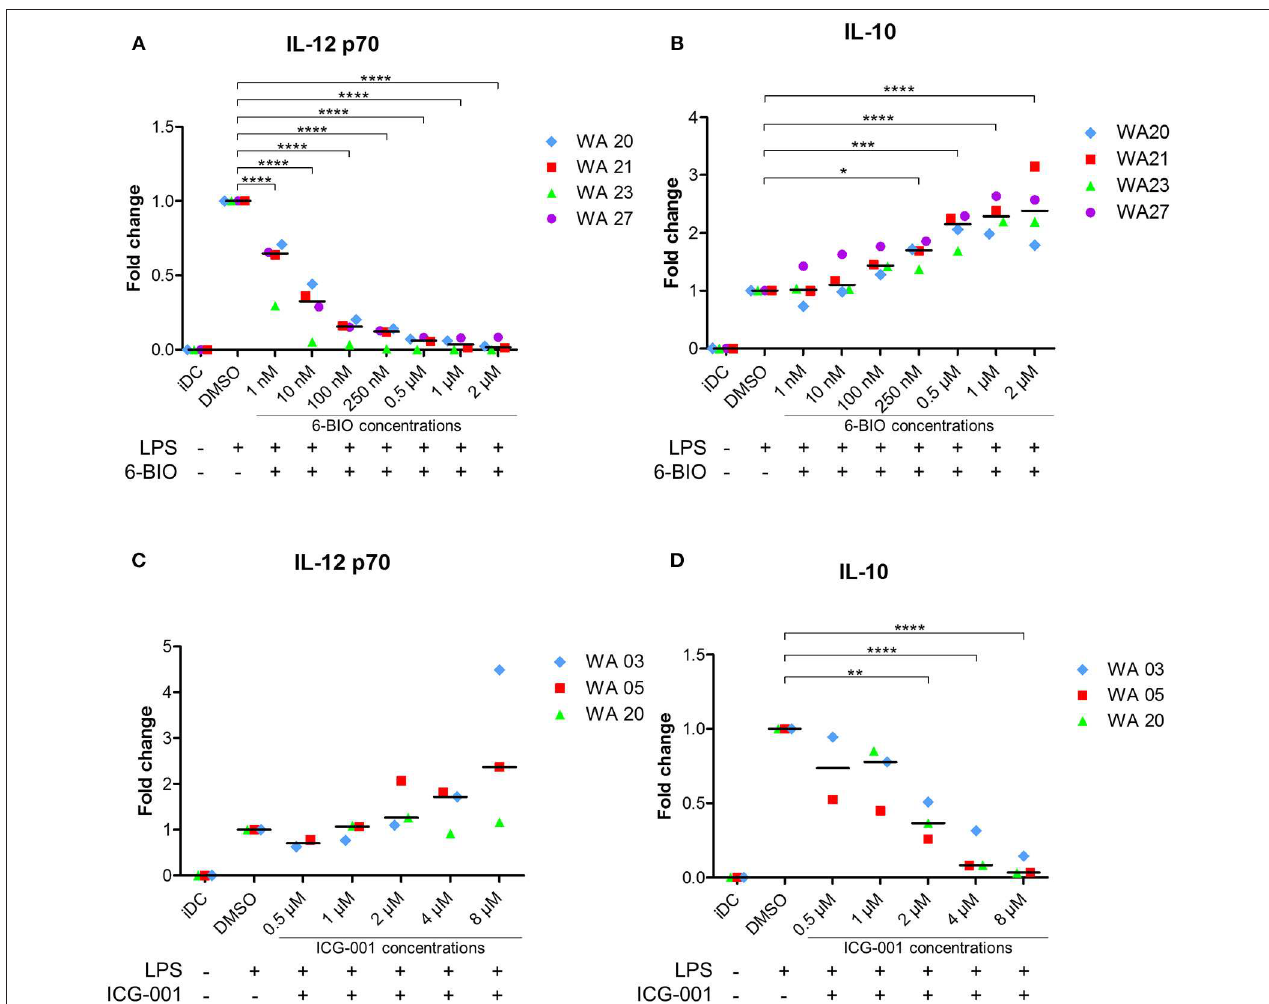
FIGURE 2 | moDCs obtained from healthy donors were treated with indicated concentrations of 6-BIO or ICG-001 or DMSO for 24h with 30ng/ml of LPS for the last 23h or left untreated with those compounds as iDC. (A–D) The fold changes compared to DMSO controls of IL-12p70 and IL-10 in supernatants were measured by enzyme-linked immunosorbent assay (ELISA). Each symbol represents a different donor, and lines represent the median. * p ≤ 0.05, ** p ≤ 0.01, *** p ≤ 0.001, **** p ≤ 0.0001 using one-way ANOVA with Dunnett’s multiple comparisons test and 95% confidence